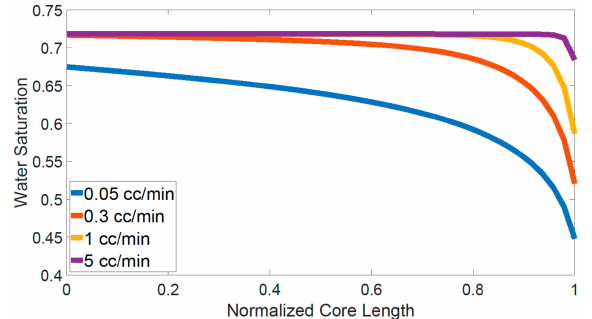
Figure 8. Water saturation profile for USS-1.